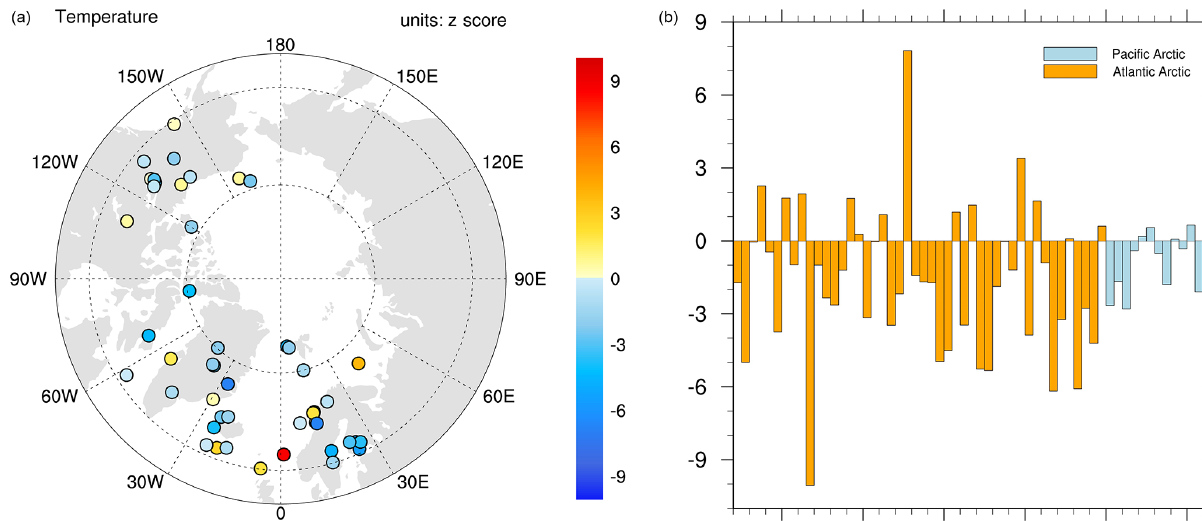
Figure 1. (a) The annual temperature changes between two periods (0–2ka minus 5–8ka) in reconstructions (Temperature 12k). (b) His- togram of temperature change for each proxy